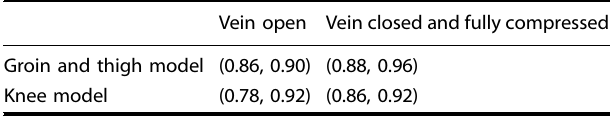
Table 3. Quantitative results for the vein compression state task of the used